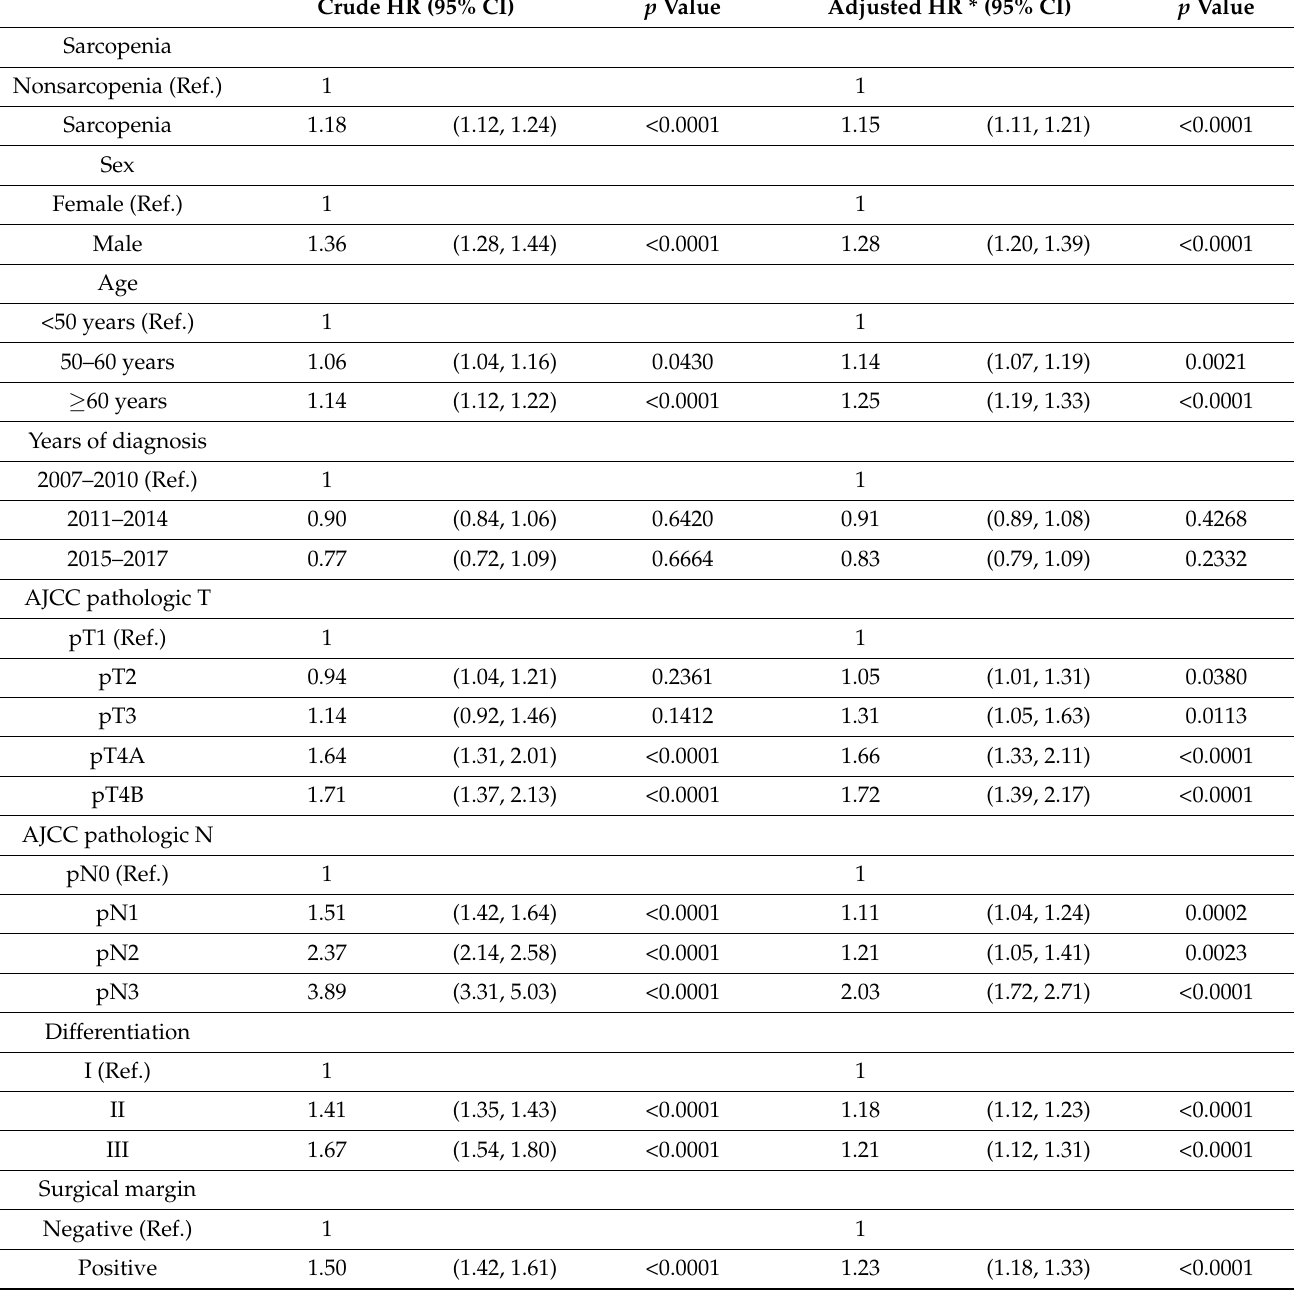
Table 2. Univariable and multivariable Cox proportional regression model for all-cause mortality of the propensity score-matched groups of patients with oral cavity squamous cell carcinoma with and without pre-existing sarcopenia. Crude HR (95% CI) p